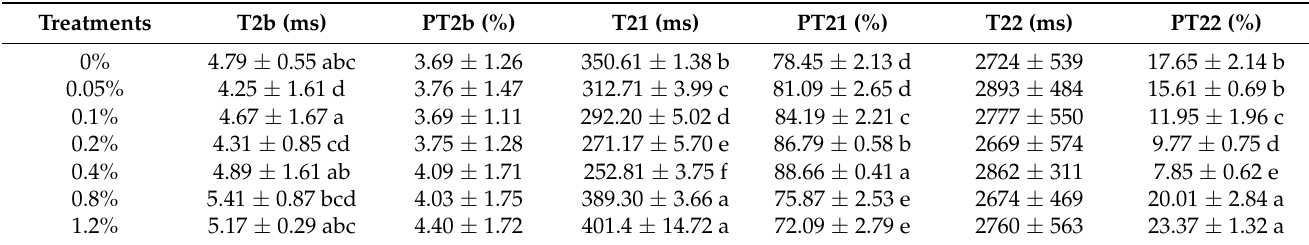
Table 2. Relaxation times and corresponding peak areas of composite MP gels with various